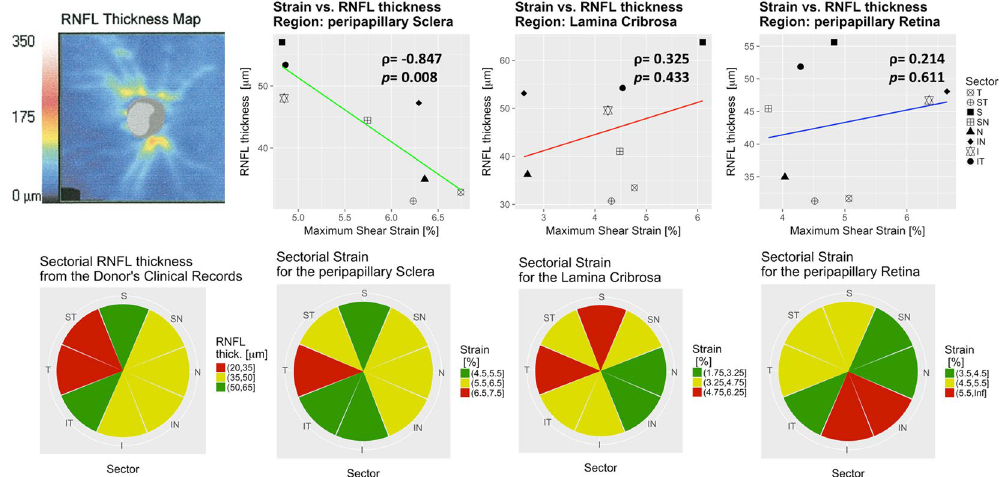
Figure 5. Strain vs. retinal nerve fiber layer (RNFL) thickness correlation. From the RNFL thickness map obtained donor’s clinical records (column 1, row 1), the RNFL map of the OD eye was computed in a conventional 8-sector clock-hour map (r2, c1). Pearson’s correlation of the RNFL thickness as a function of the maximum shear strain showed a strong correlation for the region of the peripapillary sclera ( ρ = − 0.847, p-value = 0.008; c2) while neither the strain in the lamina cribrosa or peripapillary retina showed a correlation with RNFL thickness (p-value = 0.433 and p-value = 0.611; c3 and